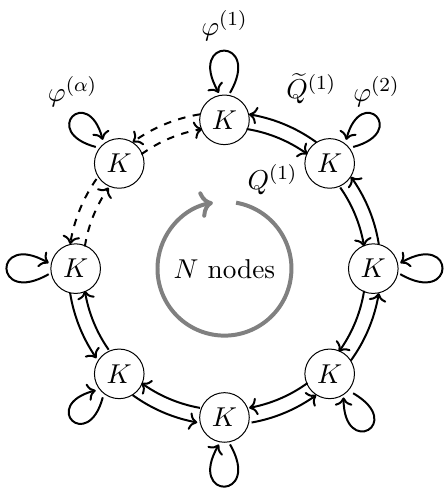
Figure 3 . The circular quiver with gauge group SU( K ) . The nodes denote N = 1 vector multiplets. The black arrows denote N = 1 chiral multiplets and ϕ ( α ) , Q ( α ) , e Q ( α ) their respective lowest